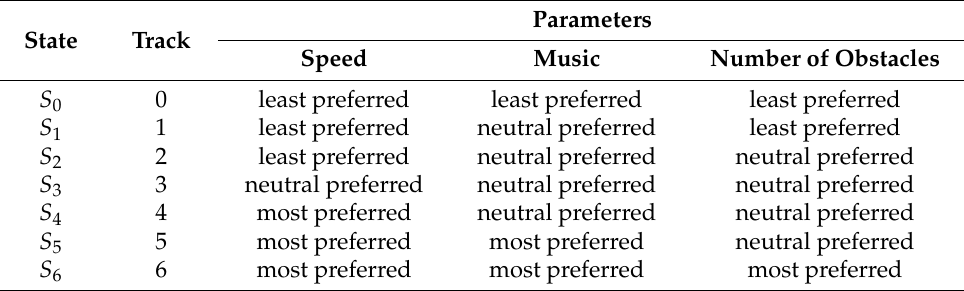
Table 3. Mapping of the user’s preference selection to the video game states/tracks: speed, music, and the number of obstacles. The parameters are selected at the user profile acquisition stage and are defined in three values: least preferred, neutral preferred, and most